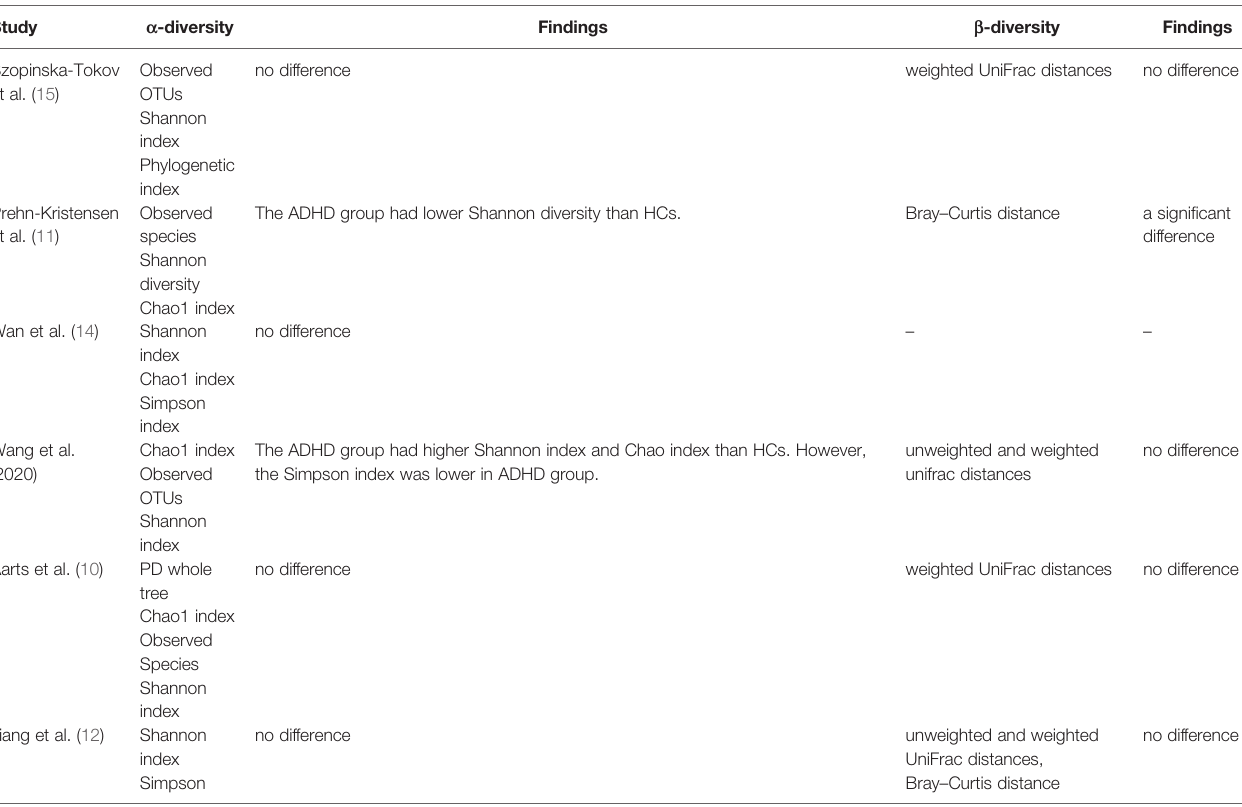
TABLE 3 | Summary of diversity assessments in the included